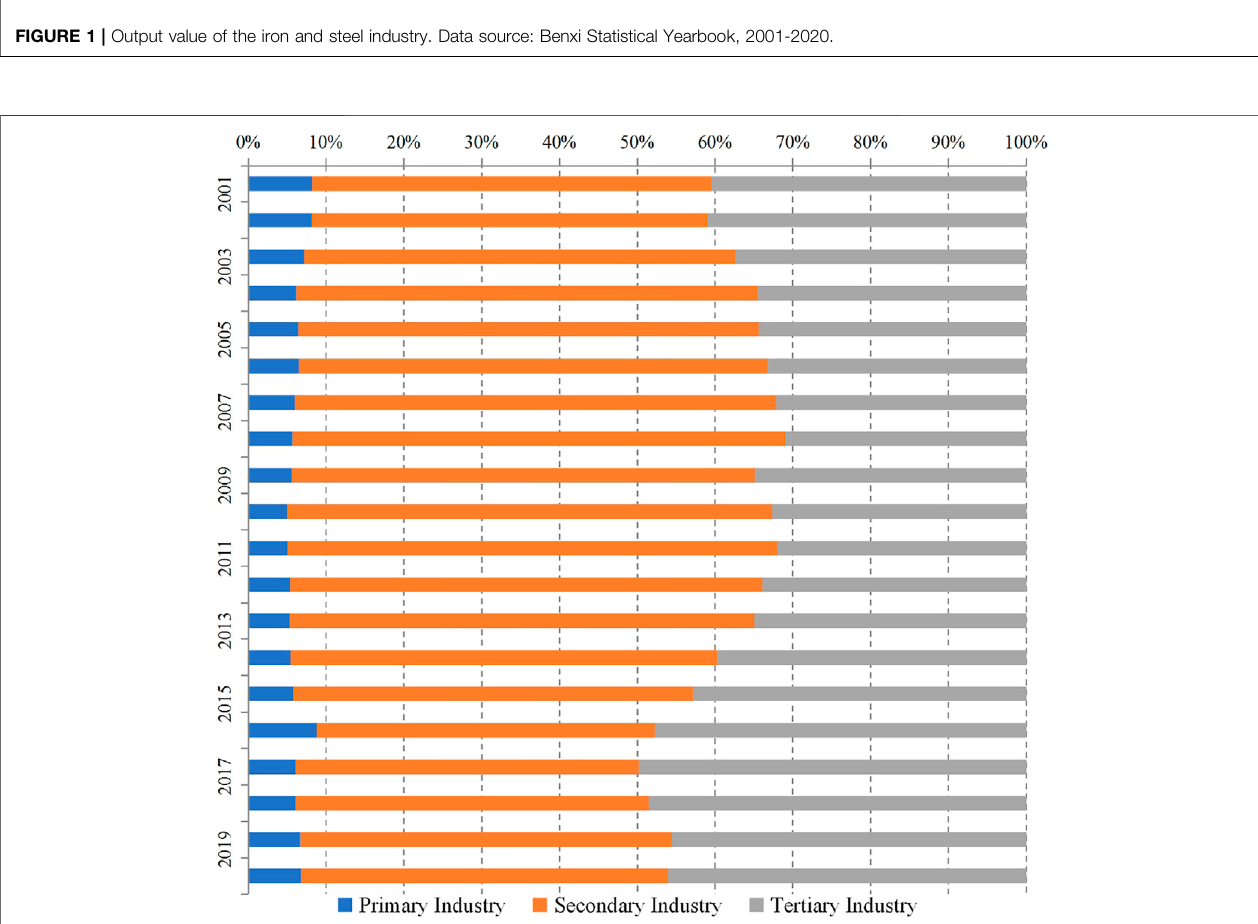
FIGURE 2 | Industrial structure, Benxi, 2001-2020. Data source: Benxi Statistical Yearbook, 2001-2020.